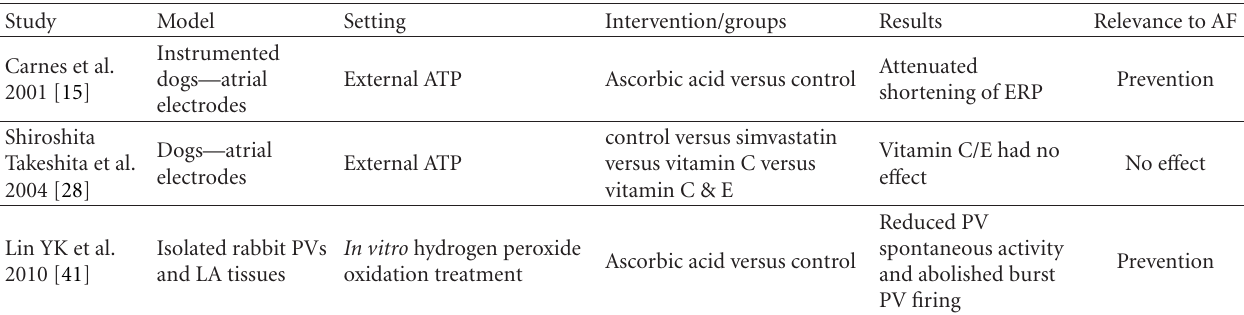
Table 1: Summary of experimental evidence for antioxidant vitamins in AF prevention.